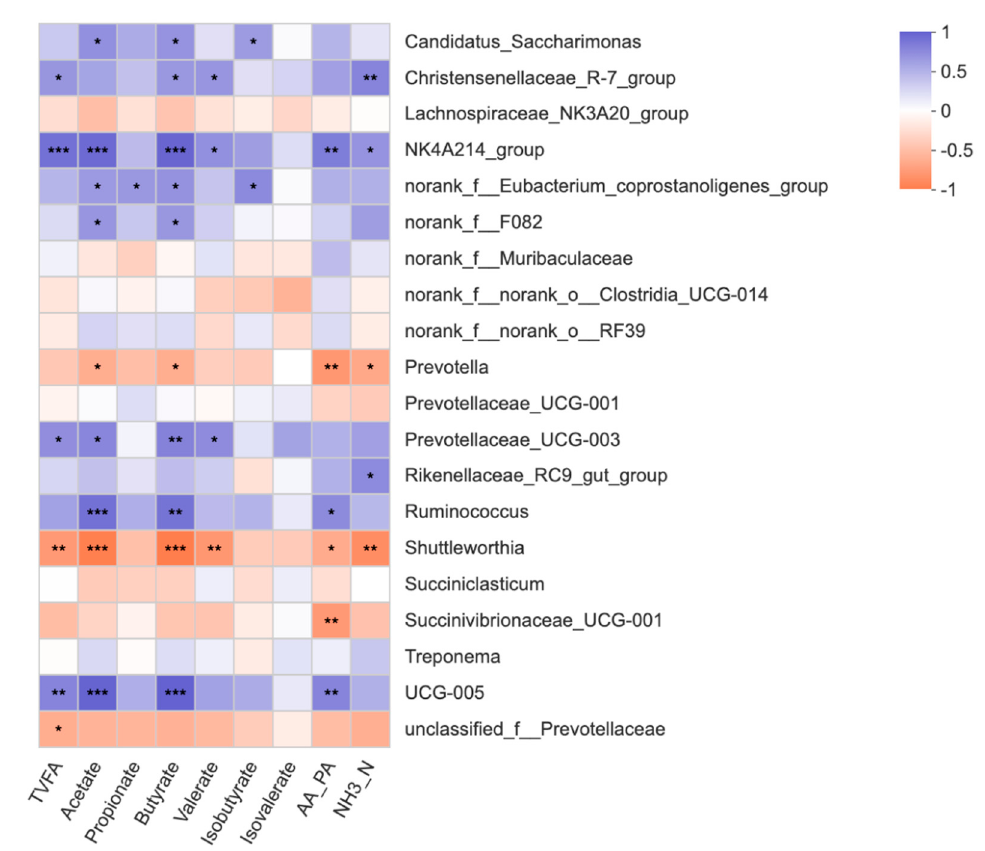
Figure 4. Correlation analyses between the fermentation characteristics and top 20 rumen bacterial genera. The blue squares represent the positive correlations while orange ones represent the negative correlations. * p < 0.05; ** p < 0.01; *** p < 0.001. NH 3 -N = ammonia nitrogen, AA/PA = the ratio of acetate to propionate, TVFA = total volatile fatty acid.